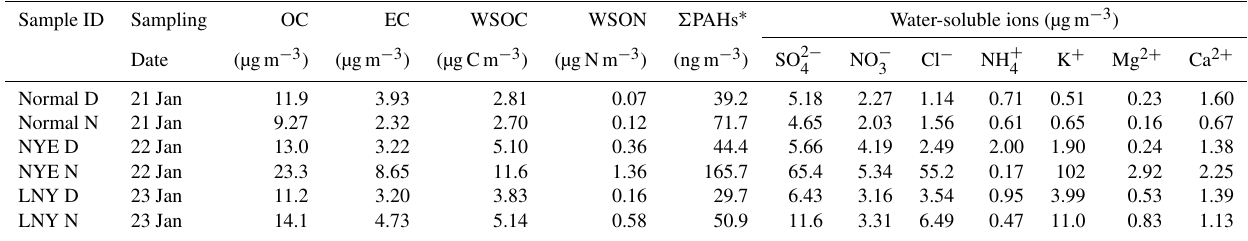
Table 1. The concentrations of chemical components in the Beijing aerosol